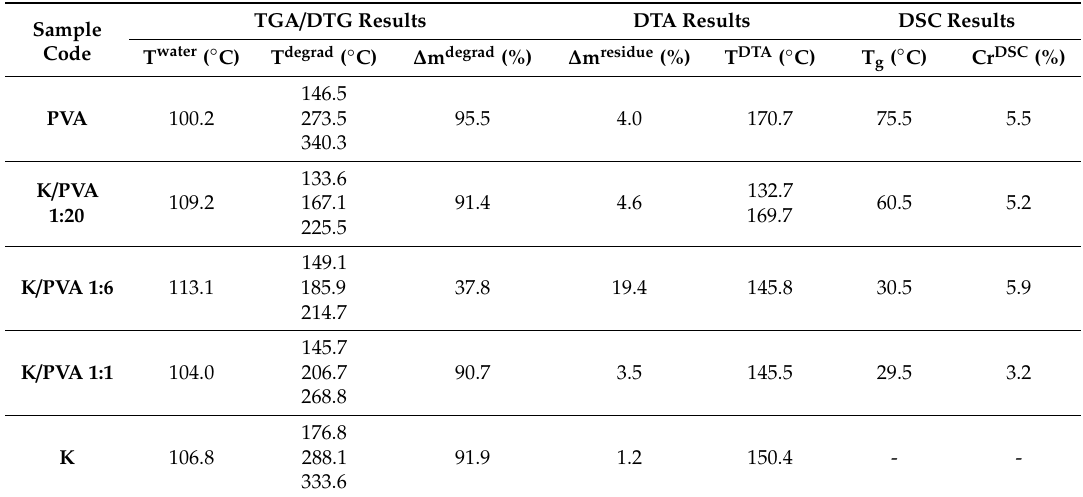
Table 3. The thermal properties of the PVA / CAR hydrogels according to the TGA, DTA and DSC thermogram